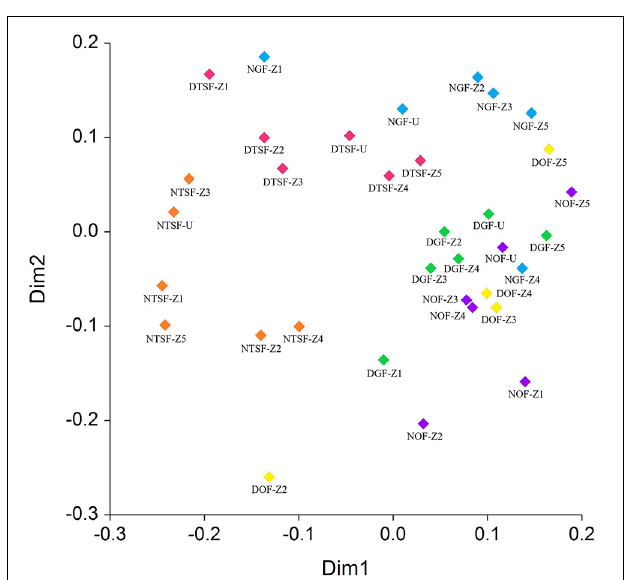
FIGURE 11 | Ordination site scores in two dimensions generated by non-metric multidimensional scaling (NMDS) using the Sørensen dissimilarity index of epiphytic angiosperms floristic composition per vertical zone (Z1, Z2, Z3, Z4, Z5) and understory (U) in each sampling site (NGF = natural gallery forest, DGF = disturbed gallery forest, NOF = natural oak forest, DOF = disturbed oak forest, NTSF = natural tropical sub-deciduous forest, DTSF = disturbed tropical sub-deciduous